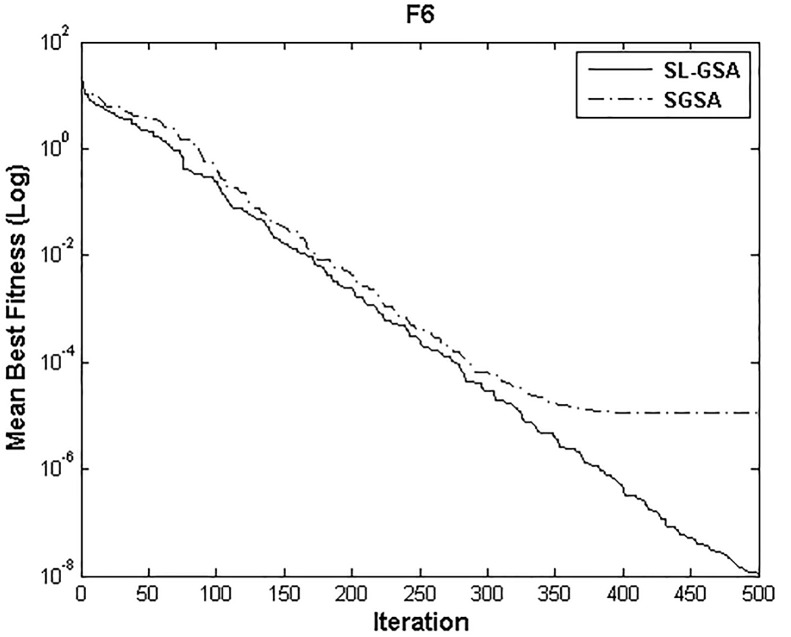
Performance comparison of SGSA and SL-GSA for minimization of F6.